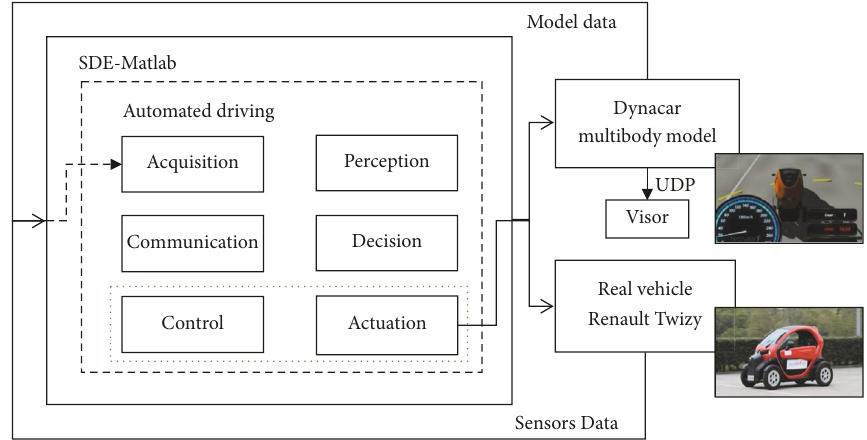
Figure 1: Test platforms and general framework.